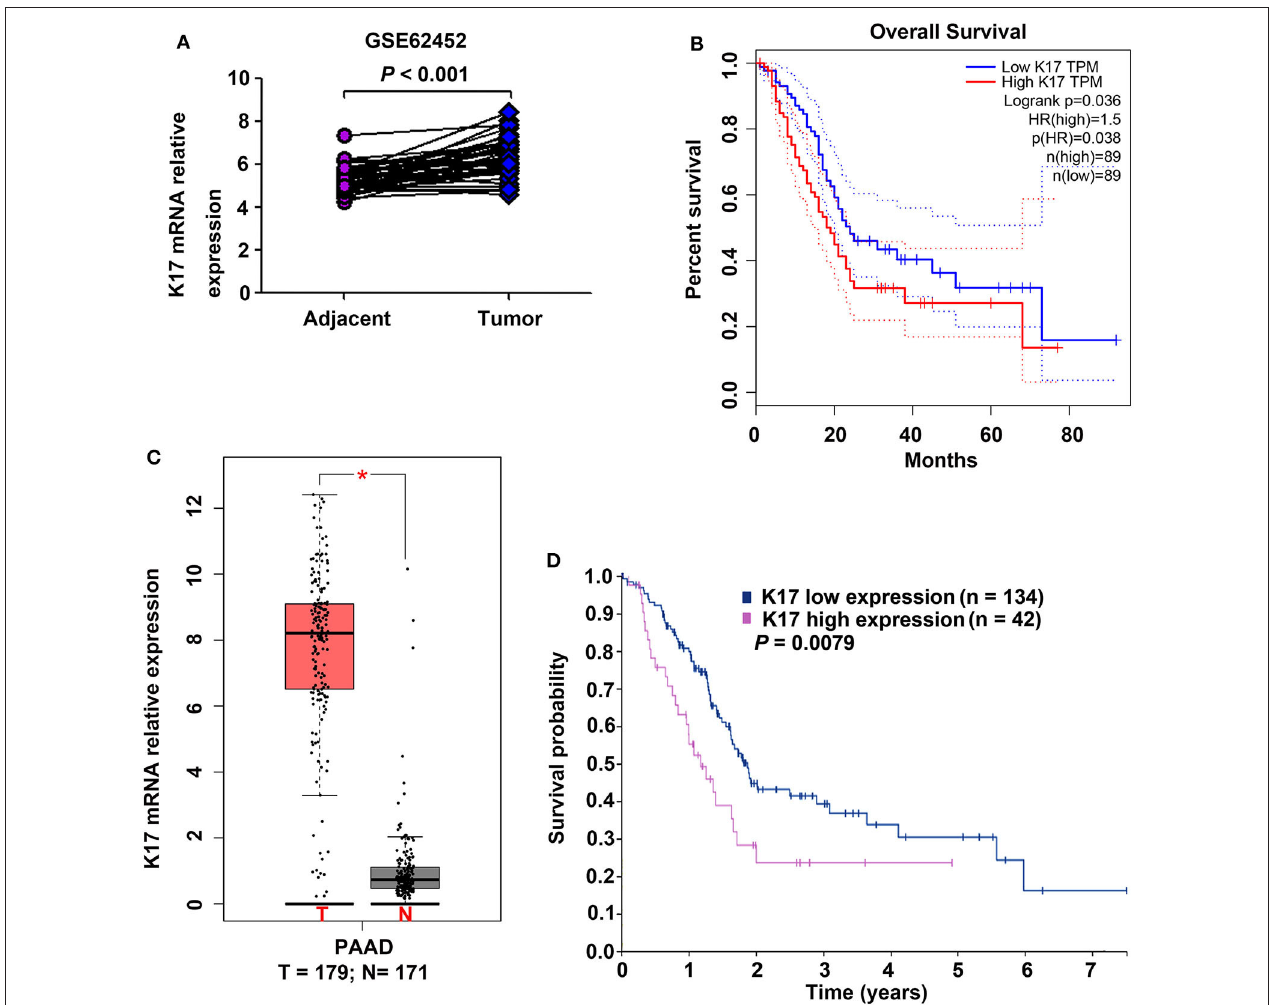
FIGURE 1 | The expression of K17 mRNA and its correlation with overall survival in pancreatic cancer. (A) K17 mRNA expression in human pancreatic cancer tissues and matched adjacent normal tissues ( n = 45 pairs) from a GEO cDNA microarray database (series GSE62452) was analyzed. (B) K17 mRNA expression in human pancreatic cancer tissues (T) and adjacent normal tissues (N) was analyzed by gene expression profiling interactive analysis (GEPIA) (C,D) The relationship between K17 mRNA expression and overall survival of pancreatic cancer patients was analyzed using the GEPIA database (C) and the Human Protein Atlas (www.proteinatlas. org/) (D) . * P <